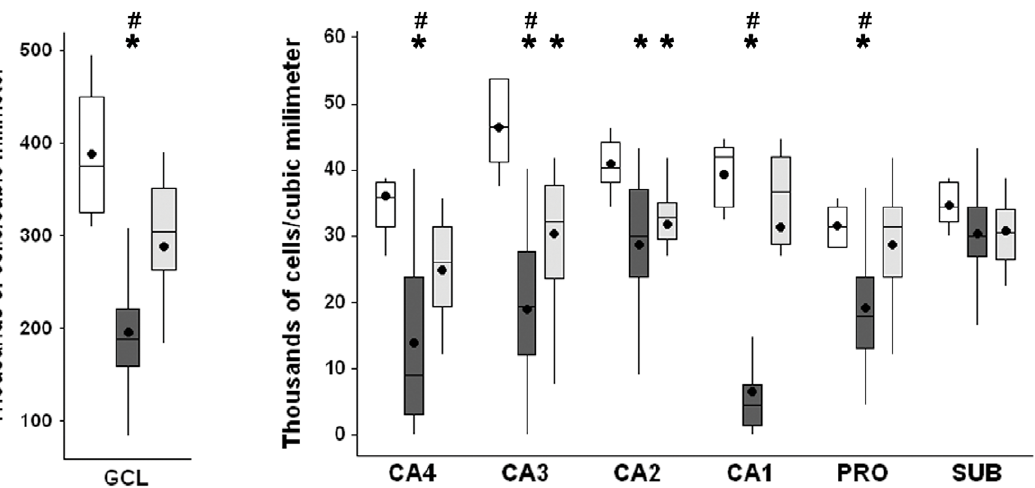
Figure 3. Neuronal density in hippocampal subfields of Ctrl, MTLE and TLE-TD groups. MTLE (dark gray boxplots) had reduced neuronal density (showed as thousands of cells per cubic millimeter), when compared to Ctrl (white boxplots) and TLE-TD (light gray boxplots), in granule cell layer (GCL), CA4, CA3, CA1 and prosubiculum, and in CA2, when compared to Ctrl (p , 0.001). TLE-TD presented decreased neuronal density only in CA3 and CA2, compared to Ctrl (p , 0.001). The * indicate difference from Ctrl and # difference from TLE-TD. The dark circles indicate mean.